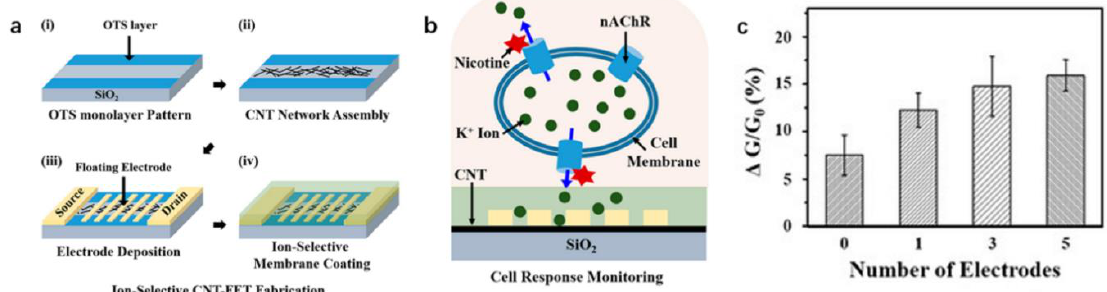
Figure 8. The schematic diagram describes the procedures for preparing sensors and measuring potassium ions released by living cells. Reproduced from Youngtak et al. [154] by permission of Molecular Diversity Preservation International. ( a ) Fabrication of the ion-selective carbon nanotube field-effect transistor (CNT-FET): ( i ) Patternization of the octadecyl trichlorosilane (OTS) layer; ( ii ) Specific adhesion of the carbon nanotubes; ( iii ) Dynamic electrode deposition on the CNT channel; ( iv ) Ion-selective membrane coating. ( b ) Direct monitoring of the response of a single cell to nicotine using ion-selective sensors. ( c ) Conductivity sensitivity of sensors with different numbers of floating electrodes to a 10 nM potassium ion